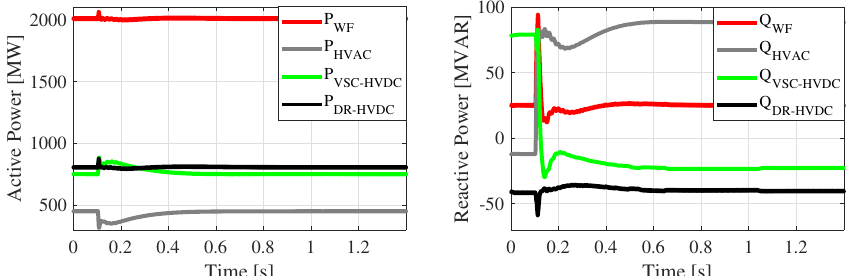
Figure 17. Active ( left ) and reactive ( right ) power of OWF and transmission lines when the offshore AC grid became weaker.